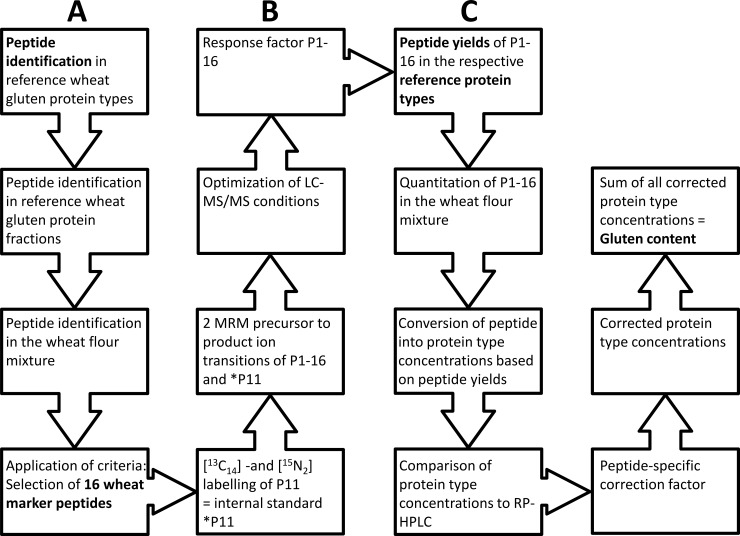
Schematic diagram showing the development of a method for the quantitation of gluten contents based on peptide yields.(A) Peptide identification and selection of 16 wheat marker peptides, (B) development of the liquid chromatography tandem mass spectrometry (LC-MS/MS) method with an isotopically labelled peptide as internal standard and optimization of the LC-MS/MS conditions, (C) quantitation of peptide yields in reference gluten protein types and conversion of peptide into protein type and gluten concentrations.